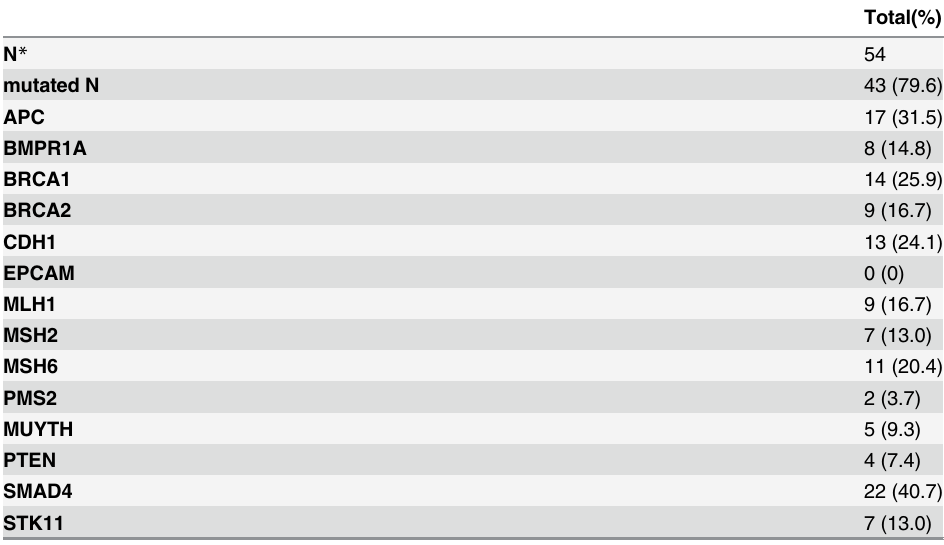
Table 3. Multigene Mutation Profiling by